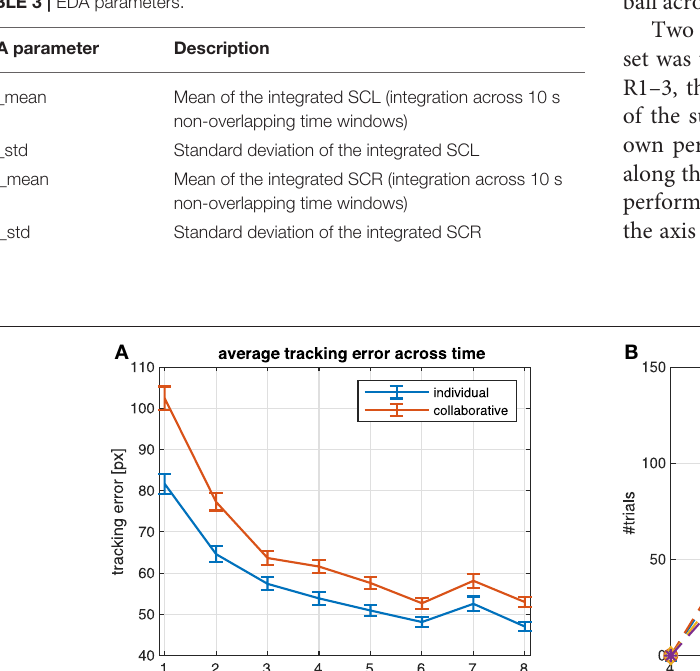
TABLE 3 | EDA parameters.